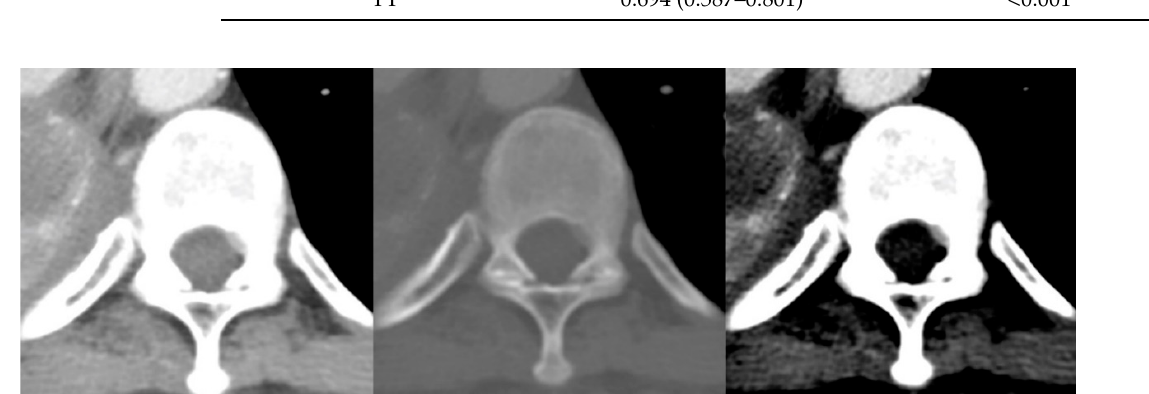
Figure 3. Subtle low-grade metastatic epidural disease at the left anterolateral spinal canal at T6. This was undercalled by all three radiologists and is challenging due to the paucity of bony change and location at the typical site for an epidural vein.